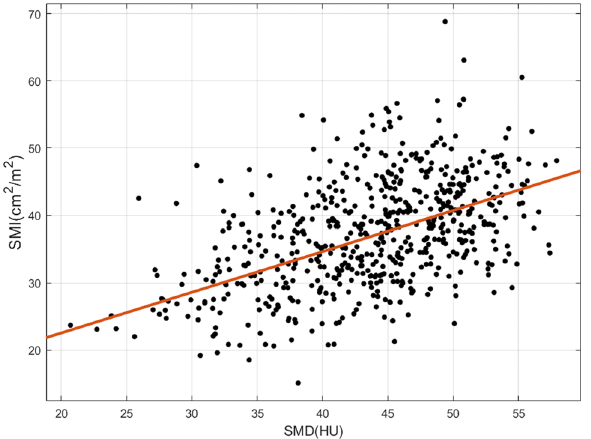
Figure 2. Correlation between skeletal muscle index (SMI) and skeletal muscle density (SMD).